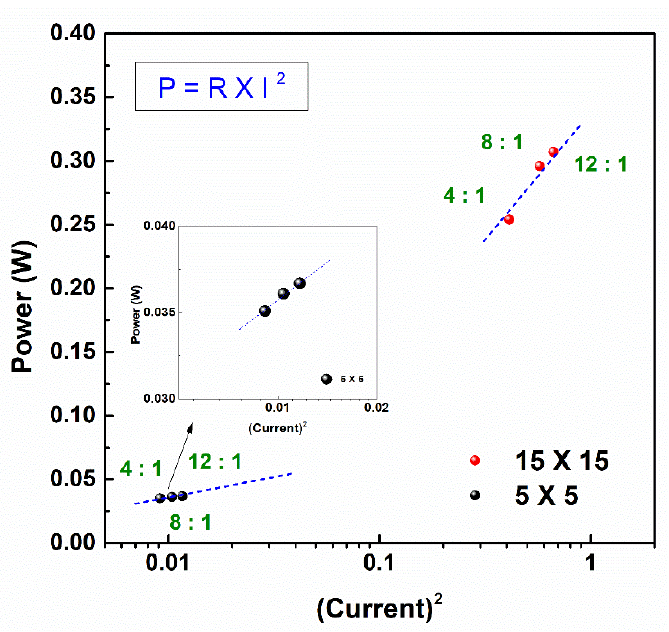
Figure 4. Relationship between the square of stack current and power according to PIEM composition and RED stack size.